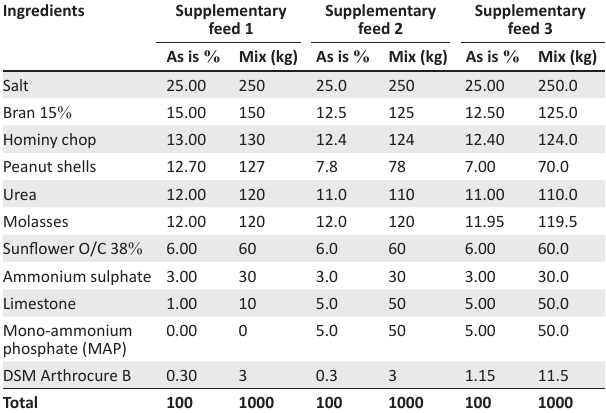
TABLE 1: List of ingredients and amounts used to formulate the respective trial